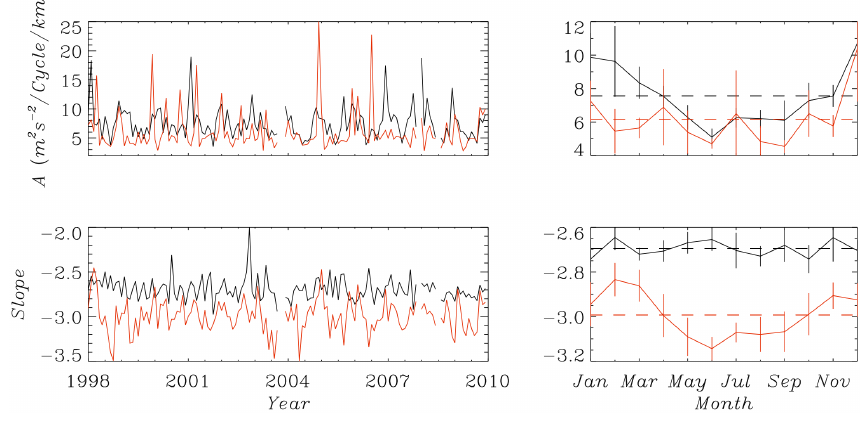
Figure 4. Same as for Fig. 3, but for meridional wind fluctuation.